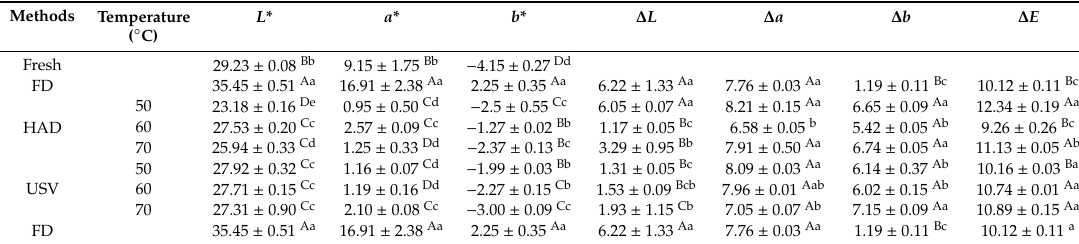
Table 3. E ff ect of color parameters of cherry laurel